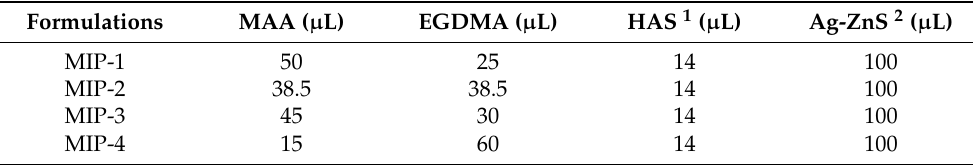
Table notes. 1 Template (human serum albumin, HSA) solution was taken from a 5 mg/mL stock solution. 2 Ag-ZnS volume was taken from a suspension of 4 mg/mL.